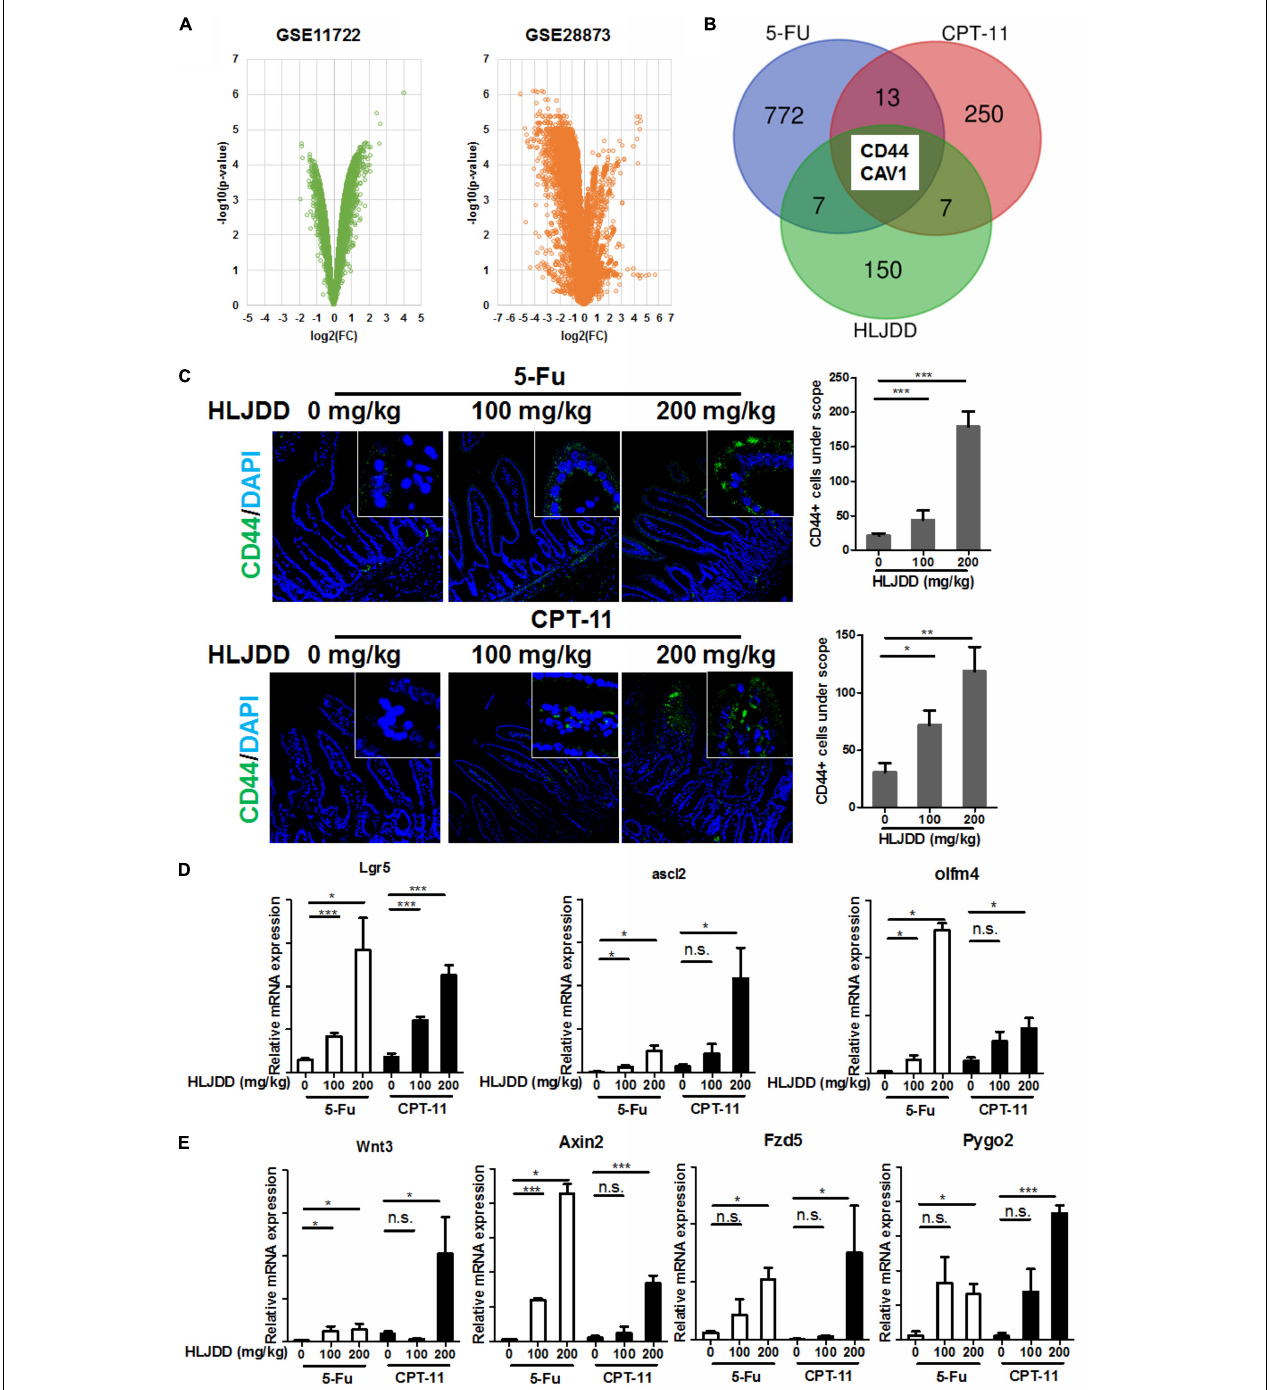
FIGURE 5 | Pre-treatment induced CD44 expression and activation of its downstream Wnt signaling in the intestinal cell of chemotherapy-treated mice. (A) showed the volcano plots of gene expression in the intestine challenged by 5-Fu (GSE28873) and CPT-11 (GSE11722). Genes with relative expression of log2(fold change) > 1 and log10( p -value) > 2 were shortlisted; (B) showed overlapped of genes with significant expression change after 5-Fu and CPT-11 treatment, and genes with expression affected by compounds in HLJDD. Tow genes, CD44 and CAV1, were the common genes among the three populations; (C) showed that pre-treatment of HLJDD could significantly improve the CD44 expression in the intestinal section of chemotherapy-treated mice; (D) showed that expression of stemness-related gene, including lgr5, ascl2 and oflm4 in the intestine cells in the intestine of chemotherapy-treated mice was induced by pre-treatment of HLJDD; (E) showed that expression of Wnt pathway-related genes, including Wnt3, Axin2, Fzd5 and Pygo2, in the intestine cells in the intestine of chemotherapy-treated mice was induced by pre-treatment of HLJDD; * p < 0.05, ** p < 0.01, *** p < 0.001 when compared with the model group.